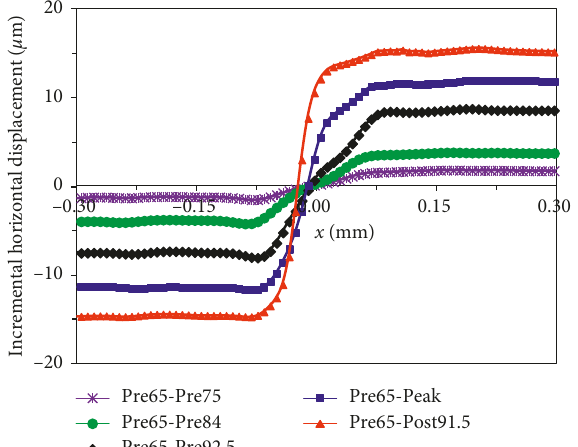
Figure 12: Variation in total horizontal incremental displacement for specimen TPB-3.0-1 along the line y different loading levels.